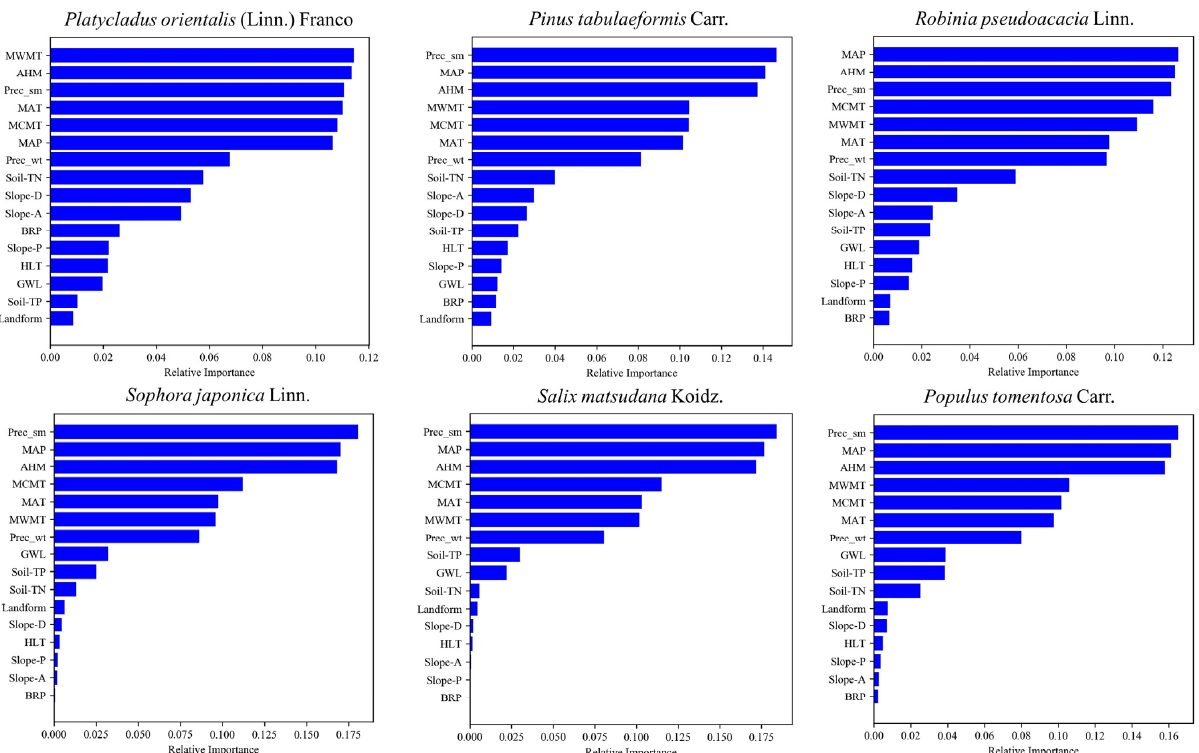
Figure 4. Map of the relative importance of environmental factors for six main tree